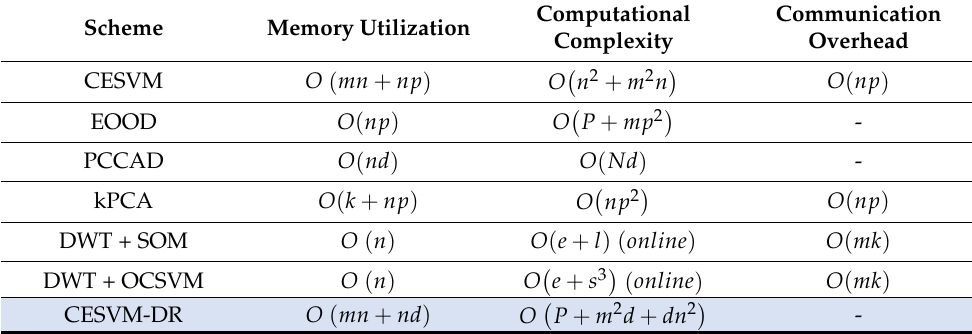
Table 4. The efficiency evaluation between CESVM-DR and other schemes.